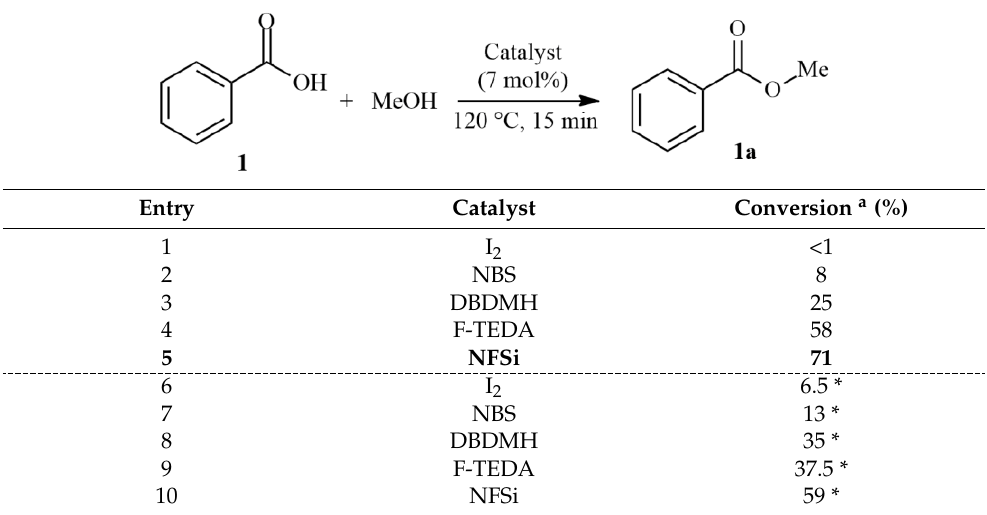
Table 1. Initial screening of MW-irradiated esterification supported by different catalysts.